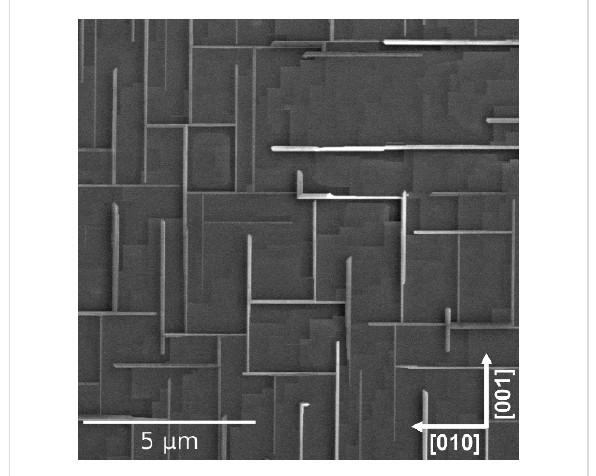
Figure 1: SEM images of an oriented network of titanium monoxide (TiO) nanowires on SrTiO 3 (100). In between the terrace structure of SrTiO 3 (100) can be